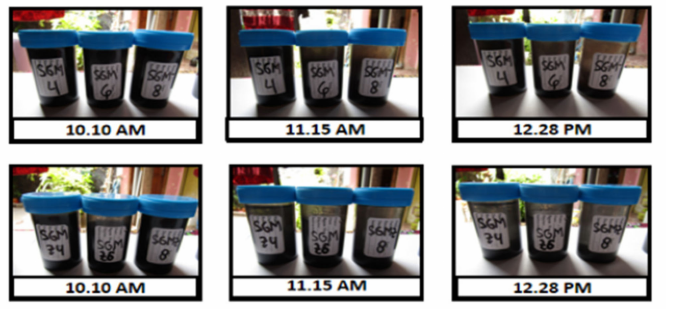
Figure 16. Colloid stability of CNS from pyrolysis of sawdust (SG) without ZnCl 2 (SMG) and ZnO/CNS from pyrolysis of sawdust (SG) with ZnCl 2 (SGMZ).